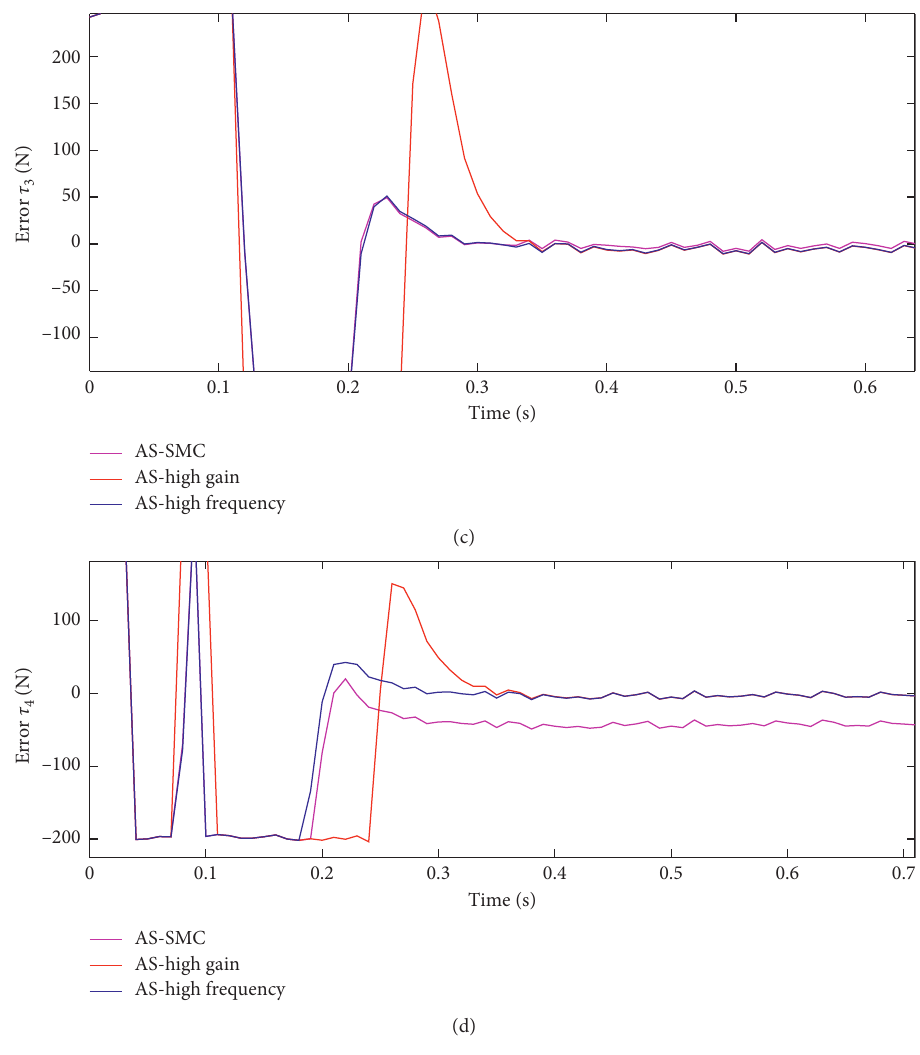
Figure 14: The force errors of partial enlargement.